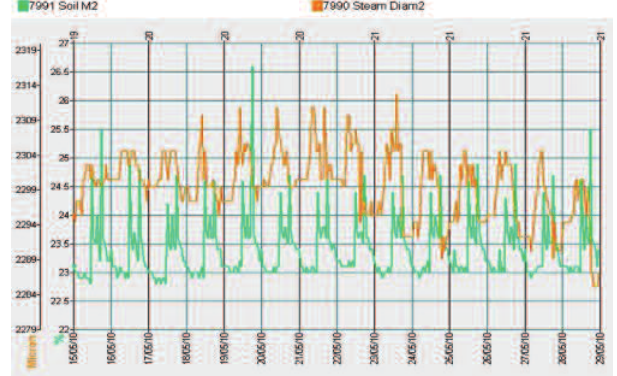
Figure 4. The expansion of rose stem in accordance with soil wetness (2010.